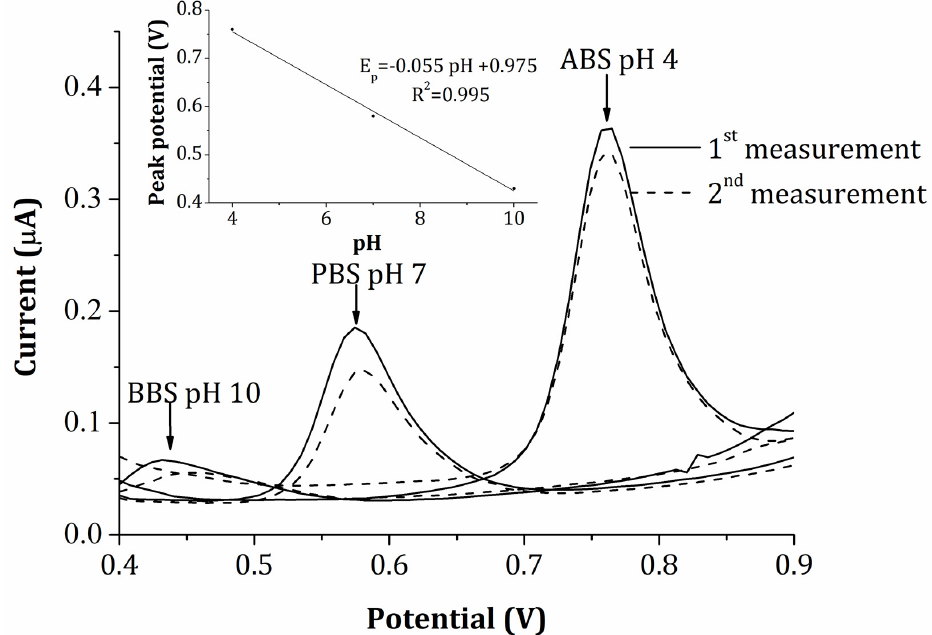
Figure 4. Differential pulse voltammograms recorded with SNG–C–2% PANI in presence of the same concentration of 4-chloro-3-methylphenol using three different buffer solutions at different pH: acetic/acetate buffer (ABS) at pH 4, phosphate buffer (PBS) at pH 7 and borate buffer (BBS) at pH 10. The inset reports the linear relationship between the peak potential and pH.